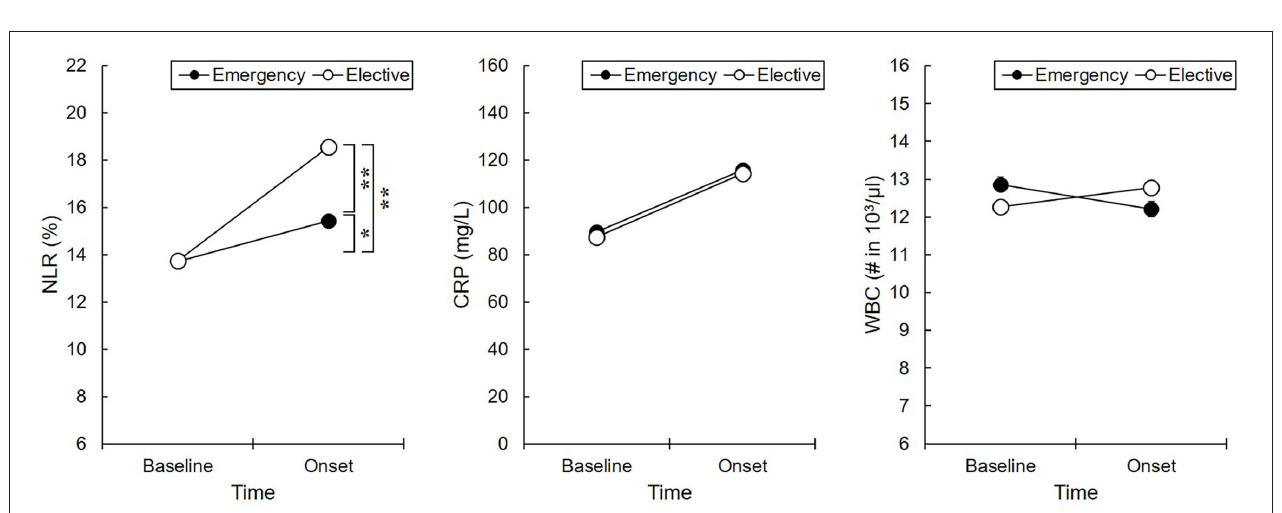
FIGURE 4 | Inflammatory responses between admission status. * p < 0.05 and ** p < 0.01. Baseline, the initial day of intensive care unit admission; Onset, the initial day of delirium onset; Emergency, emergency admission; Elective, elective admission; NLR, neutrophil-lymphocyte ratio; CRP, C-reactive protein; WBC, white blood cell. The NLR level in patients with elective admission was significantly increased than those with emergency